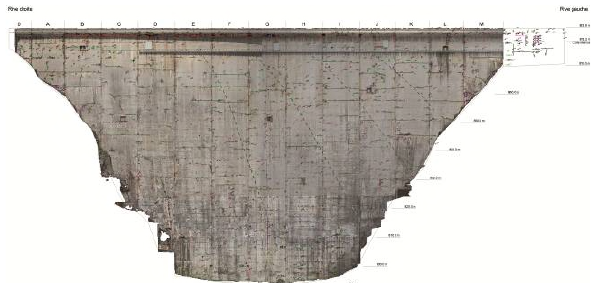
Figure 12. Map overlaying deflection/defects and magnifying